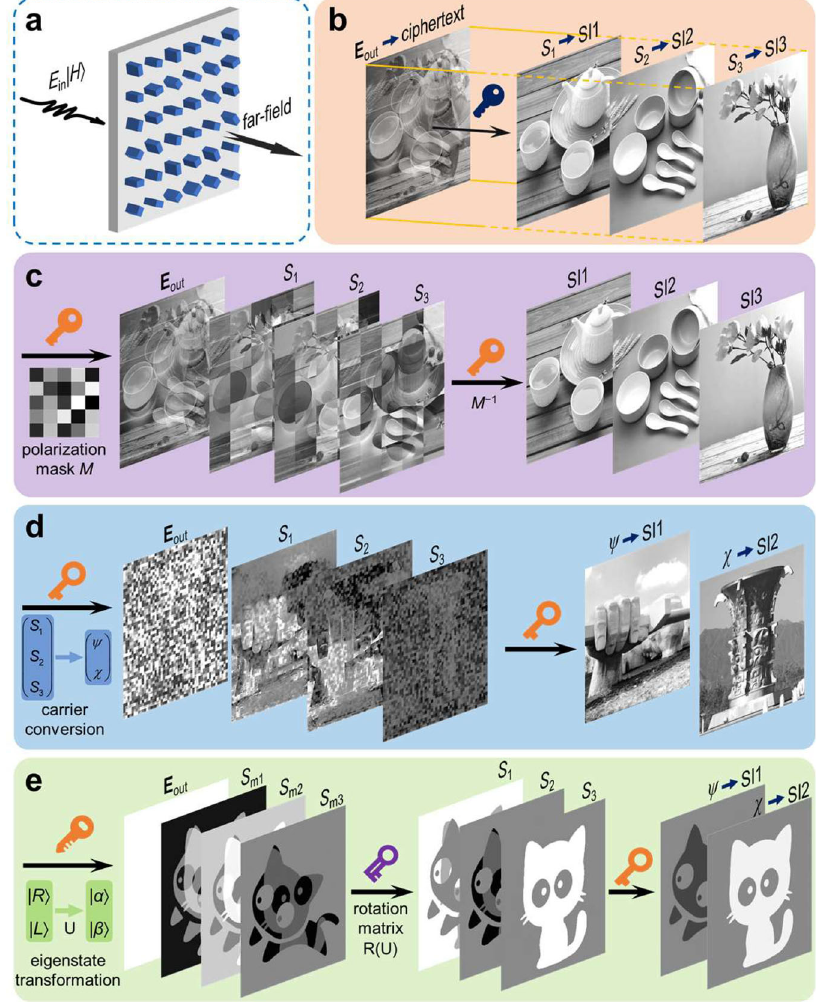
Fig. 1 | Conceptual illustration of Stokes meta-hologram. a , b Fundamental Stokes vector encryption. The meta-hologram generates a fully-polarized far- fi eld E out (asciphertext)encryptedwithsecretimages (SI)inStokesvector,i.e.,(SI1,SI2, SI3) T =( S 1 , S 2 , S 3 ) T , when it is illuminated with a uniform light beam of | H 〉 polar- izationstate. c Muellermatrixencryption.Apixeledpolarizationmask(depictedas Mueller matrix M ) is used to perform the second-level encryption, in which